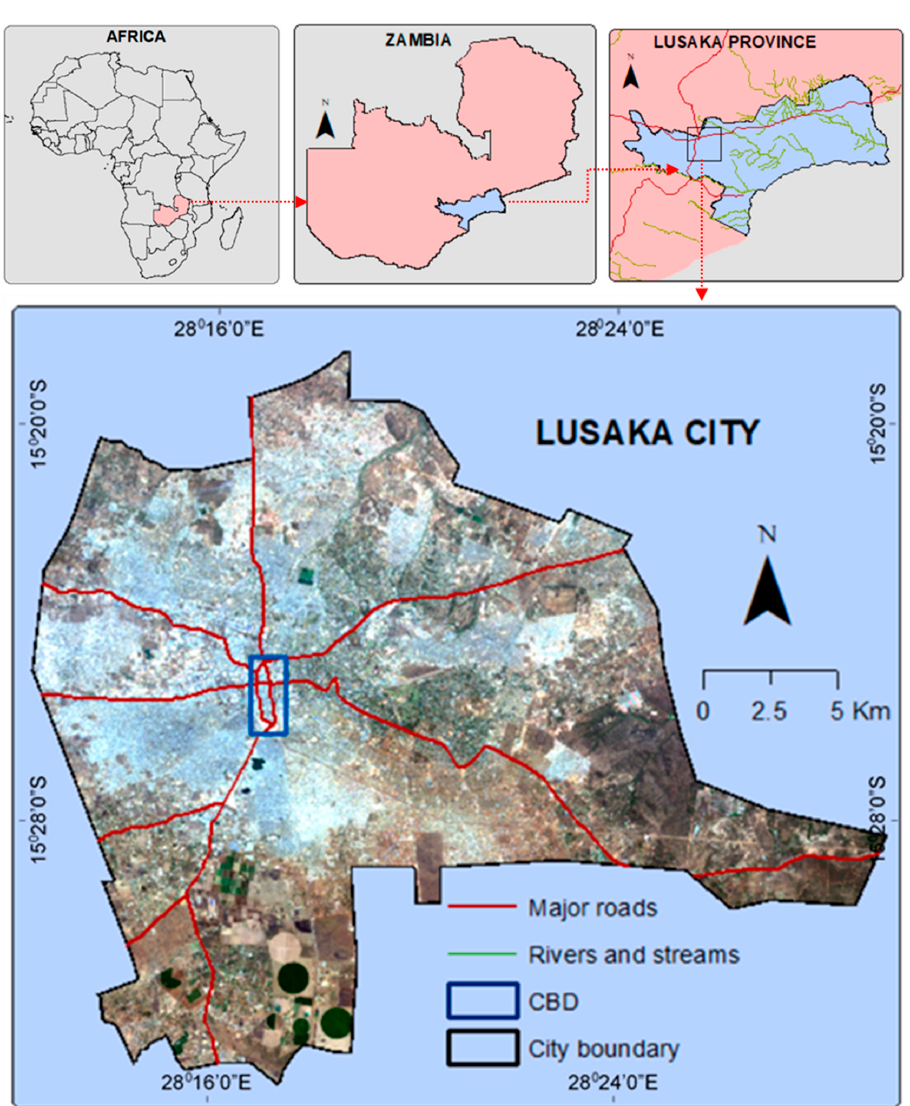
Figure 1. Study area: Lusaka city, located in the Lusaka Province of Zambia.